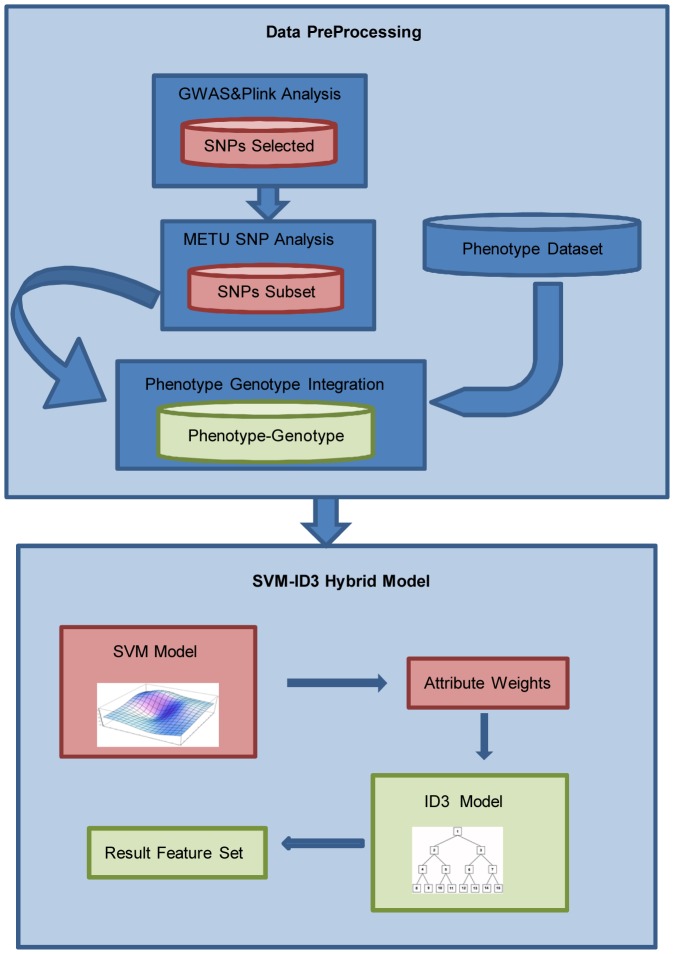
Overall Work flow of the SVM-Tree Hybrid Model.Overall workflow starts with data preprocessing where representative SNP subset is formed by Plink and METU-SNP analysis, phenotype and genotyping data integrated and missing values are either eliminated or manually filled by class mean calculation. After the data preprocessing, integrated dataset is fed into hybrid model where SVM model gives the attribute weights which are used in ID3.